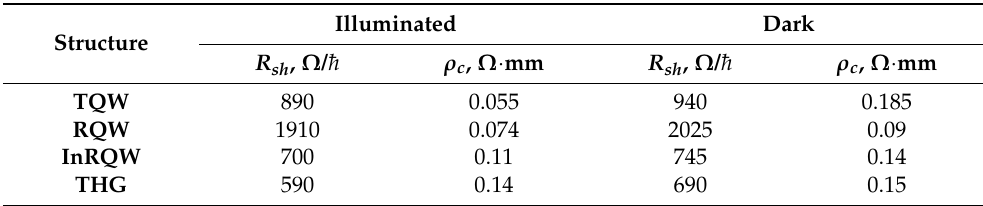
Table 2. Sheet resistance R sh and specific contact resistance ρ c of the planar, asymmetrically necked diodes in dark and under